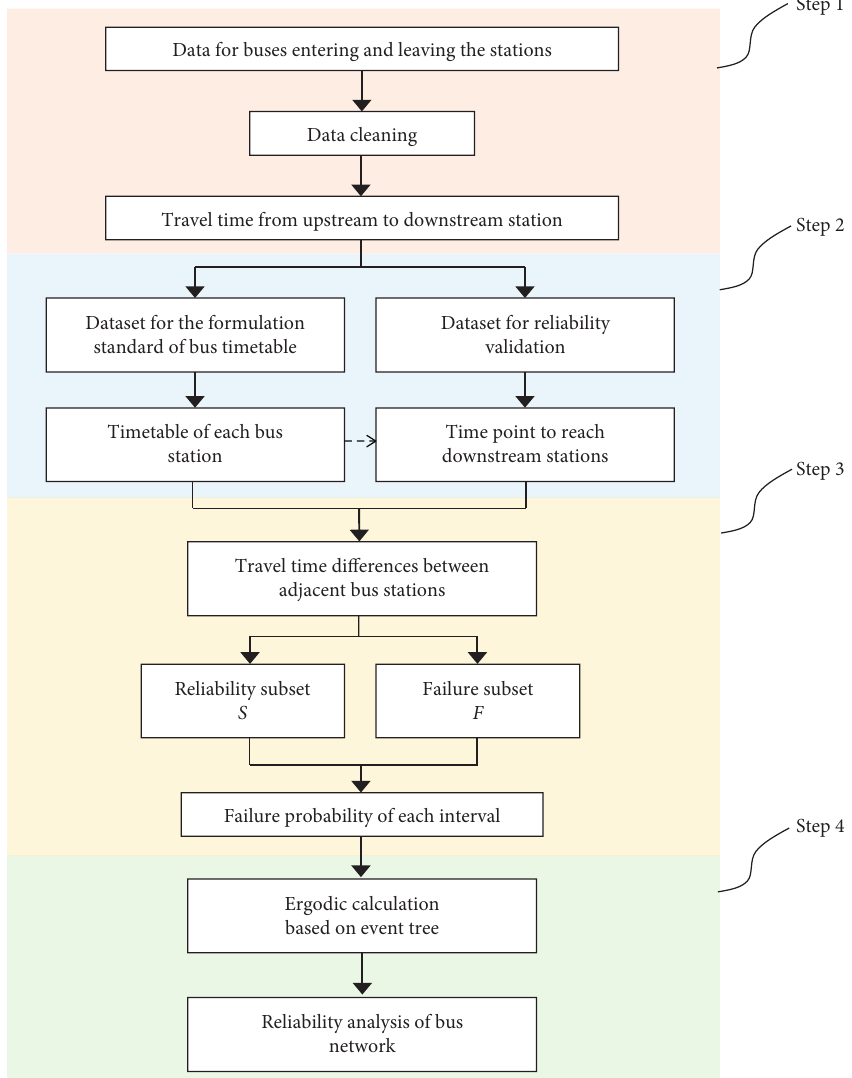
Figure 4: Flowchart for the reliability assessment of the bus